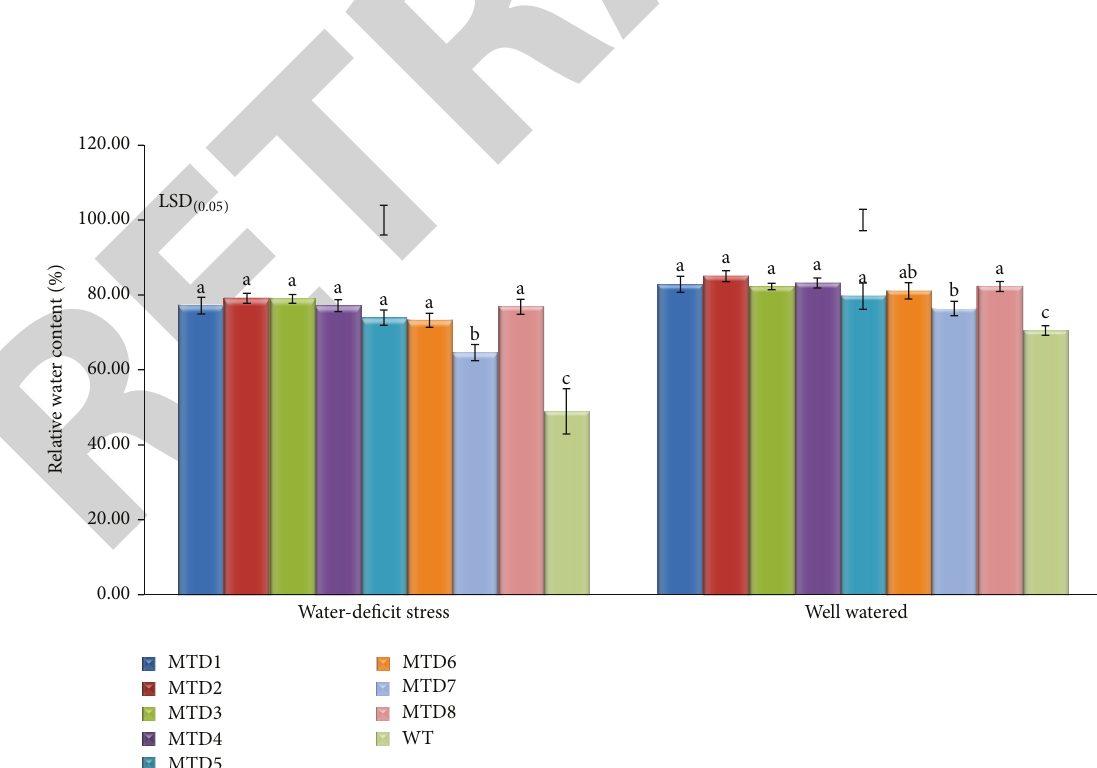
Figure 6: Effect of imposing water-deficit stress at full-growth stage in transgenic lines (MTDs) and WT (GG 20) on RWC content. Values are mean of three replicates and bars indicate ± SE; bars on the top represent the LSD 0.05 . Bars having same lower-case letters within treatments are not significantly different ( 𝑃 ≤ 0.05